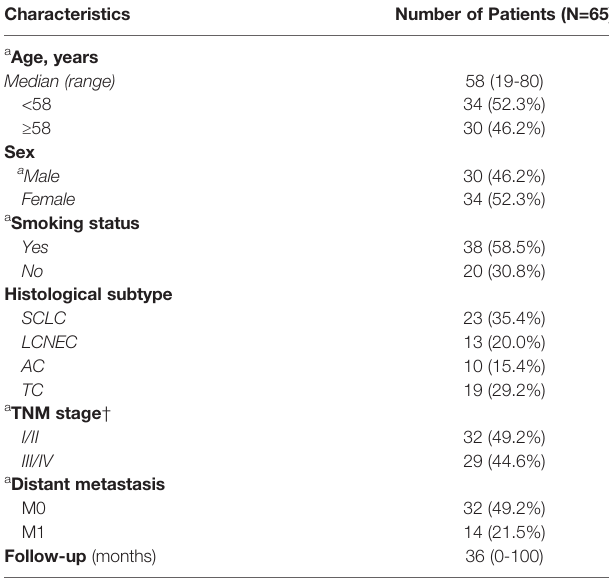
TABLE 3 | Frequency of demographic and clinical characteristics of PNENs patients.